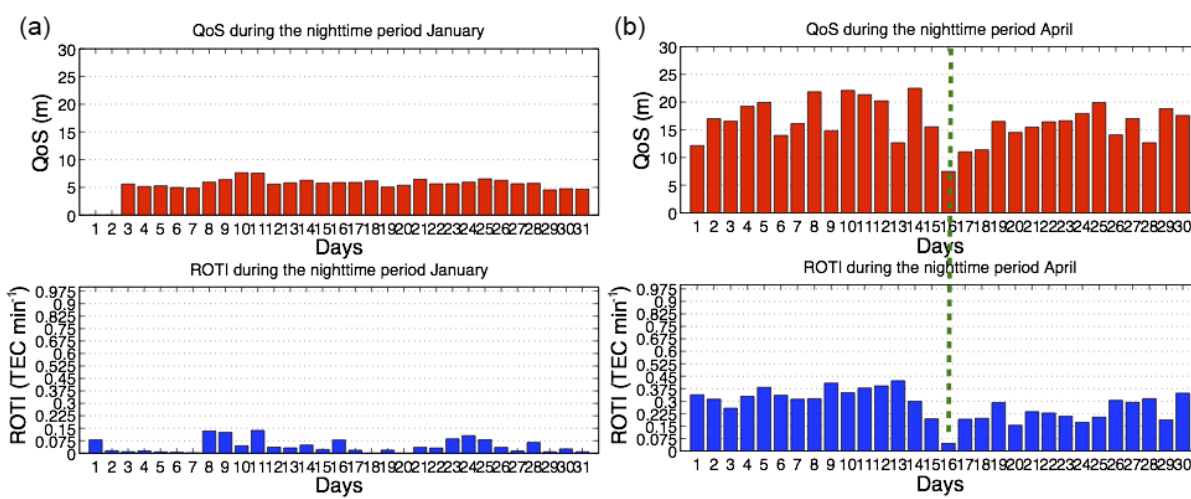
Figure 2. Correspondence of ionospheric irregularity inhibition with SBAS performance in January (left) and April (right)